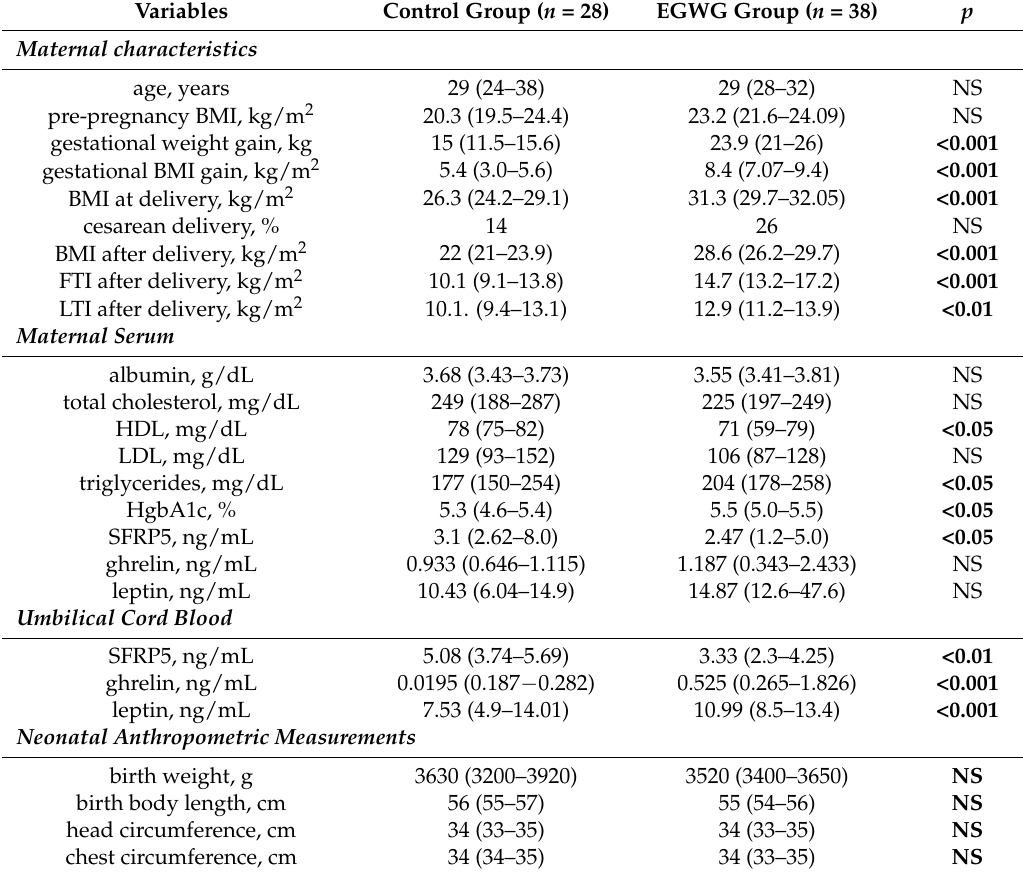
Table 1. Comparison of characteristics of the study